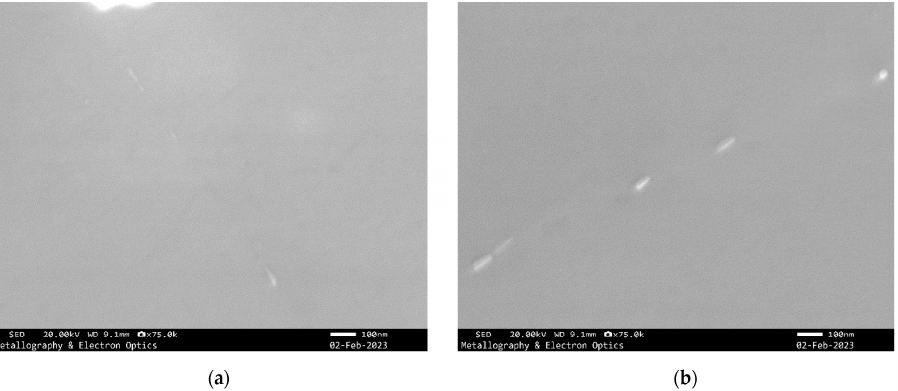
Figure 7. In AOI 3, grain boundary precipitation on LA boundaries ( a ) and HAG boundaries ( b ) of the SC sample. The differences in length (i), thickness (ii), and inter-particle distance (iii) of the precipitates were noticed.